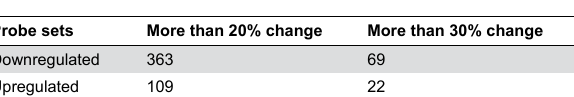
Table 1. Transcriptional changes between WT and Hdac4 KO P3 brains as detected by Affymetrix array profiling.